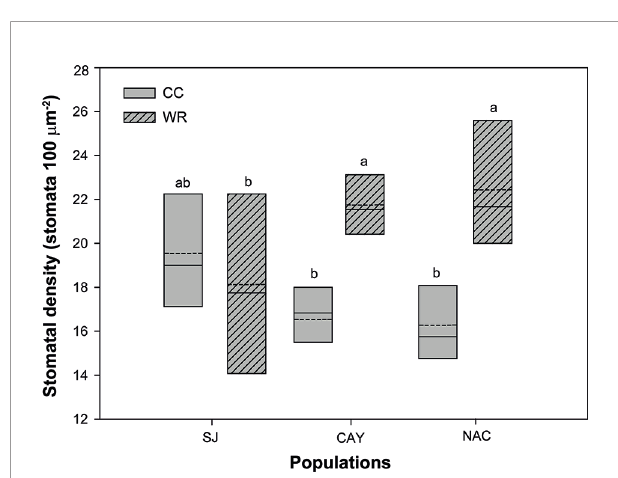
FIGURE 8 | Population and water restriction treatment signi fi cantly interacted to affect stomatal density of Persea lingue plants. Water restriction (WR) increased stomatal density in plants from Cayumanque (CAY) and Nacimiento (NAC) compared to plants at container capacity (CC), while it had no effect on Santa Juana (SJ). Bottom and top boundaries of the boxes represent the 25 th and 75 th percentiles, respectively. The solid line in the center of each box represents the mean value and the dashed line represents the median value. Different letters indicate signi fi cant differences among populations and the irrigation treatments according to Tukey at